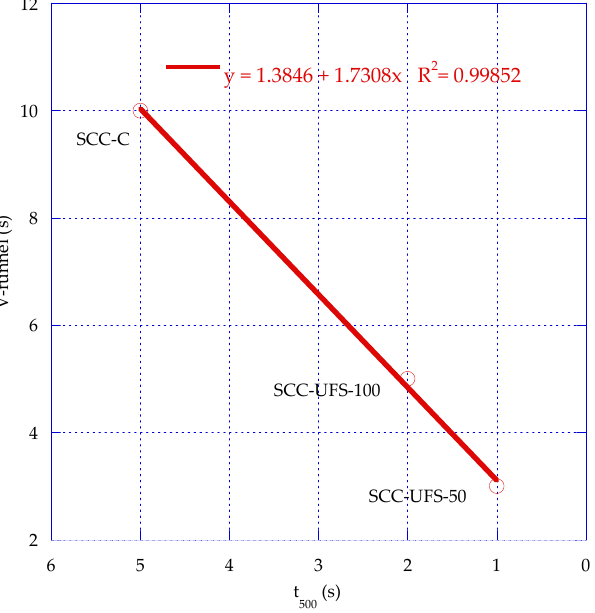
Figure 4. Time reduction of t 500 test and V-funnel test.